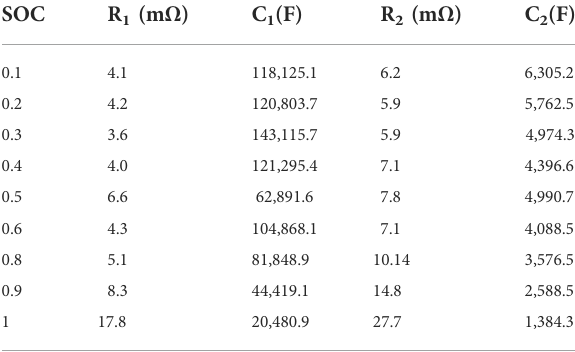
TABLE 2 The identi fi cation result of R 1, R 2, C 1, C 2